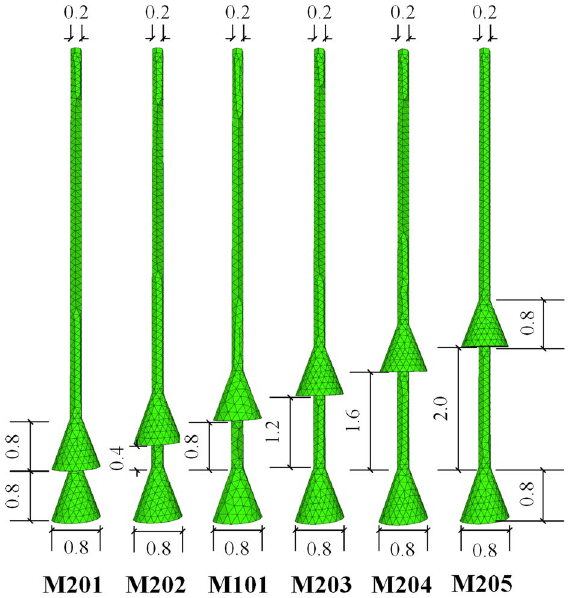
Figure 13. Diagram of group M2 anchors (Unit: